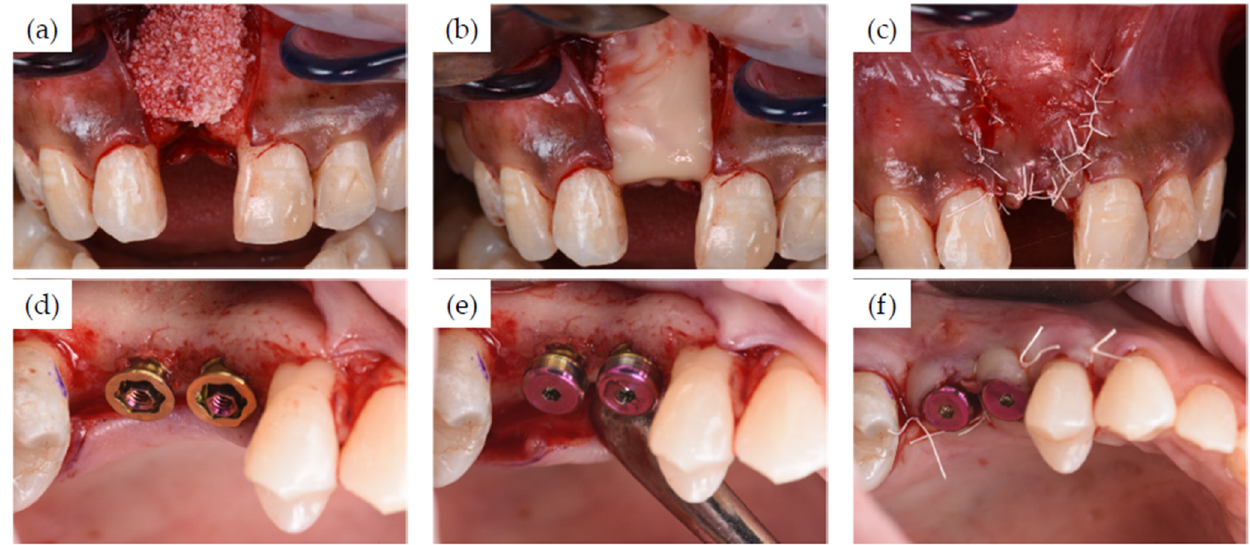
Figure 6. Flap closure. ( a – c ) An allograft and autogenous bone graft was placed ( a ) and covered with L-PRF membrane ( b ), and the flap was sutured ( c ). ( d – f ) A transmucosal base was placed on each implant at time of surgery ( d ) and connected to a healing cap ( e ). ( f ) Flap closure to facilitate the shaping of the mucosa by healing caps and the base.